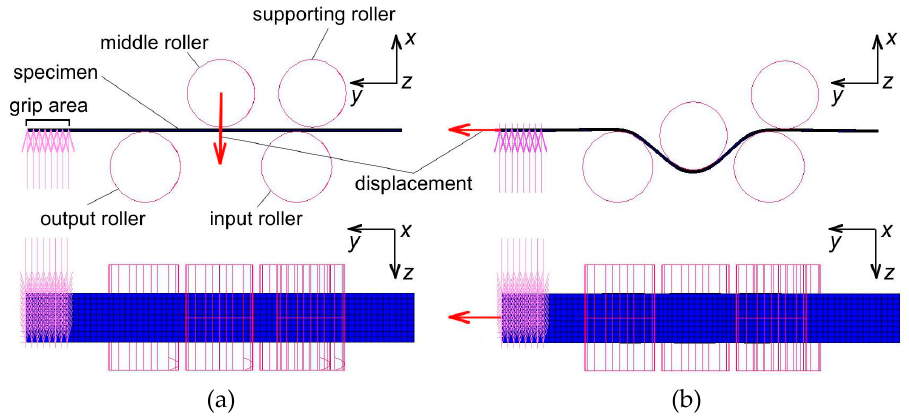
Figure 5. Geometry and boundary conditions of the Finite Element Method (FEM) model of the drawbead simulator: ( a ) first and ( b ) second stage of simulation.